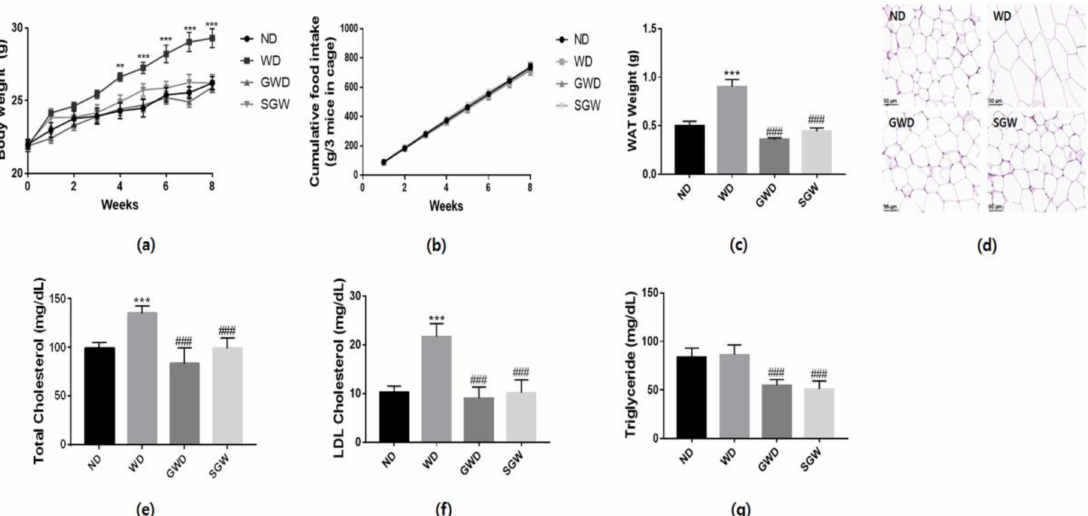
Figure 1. Changes of body and white adipose tissue (WAT) weight and lipid metabolism. ( a ) Body weight changes during the 8 weeks of feeding; ( b ) Cumulative food intake during the 8 weeks of feeding; ( c ) WAT weight; ( d ) Hematoxylin and eosin (H&E) staining of WAT; ( e ) Total cholesterol levels; ( f ) Low-density lipoprotein cholesterol levels; ( g ) Triglyceride levels. Data are presented as the mean ± SEM for nine mice per each group (** p < 0.01, *** p < 0.001 vs. ND; ### p < 0.01 vs.